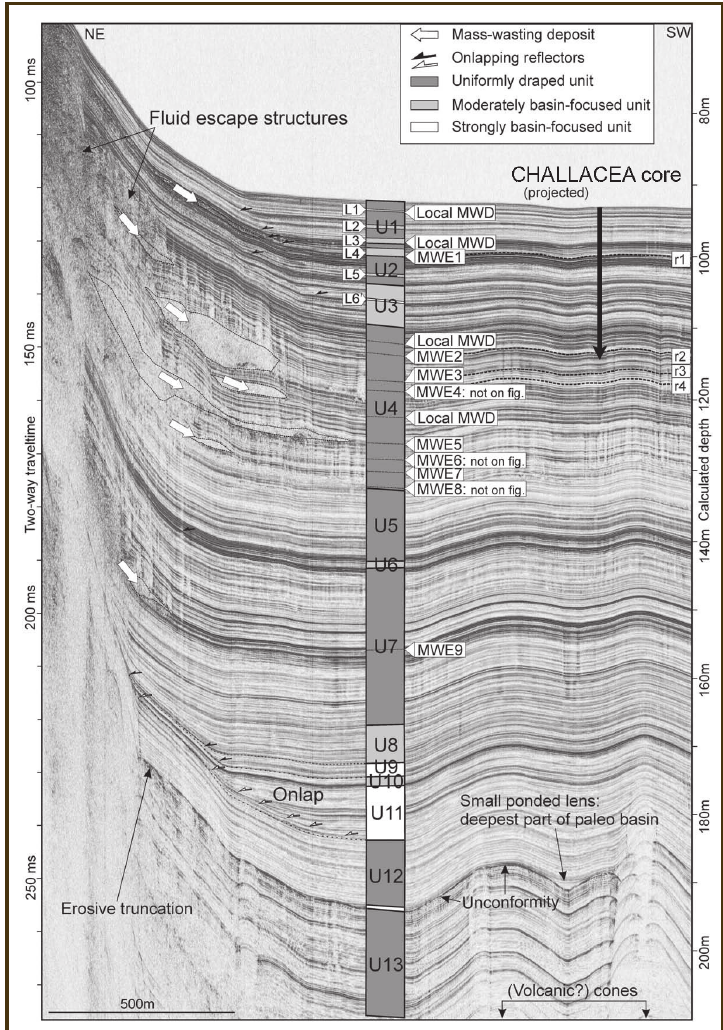
Figure 4. Seismic profile of the upper half of the lacustrine deposits in Lake Challa, based on a GeoPulse 3.5-kHz seismic-reflection survey completed by Ghent University (Belgium) in 2005. Shown are the geometry of seismic units (U1 – U13), the stratigraphic position of associated MWEs and MWDs, and projected position of the CHALLACEA core section. L1 – L6 are inferred lowstands, based on ponding sedimentation evidenced by the corresponding reflectors. Modified from Moernaut et al.